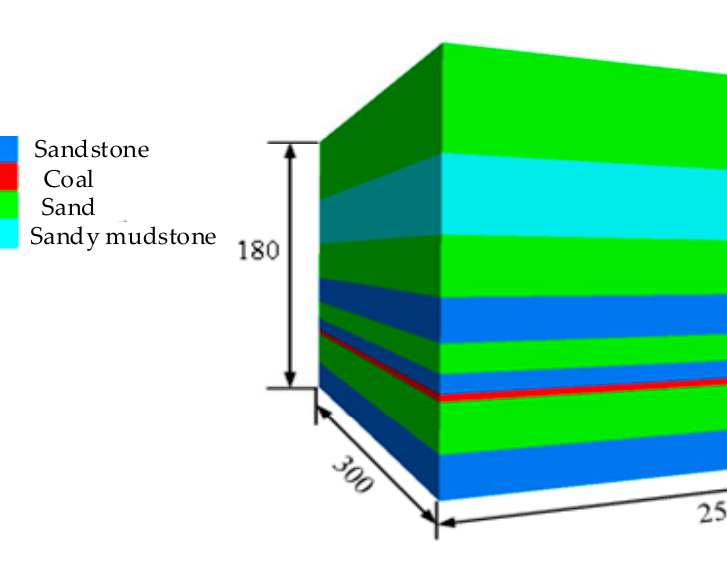
Figure 1. Diagram of the numerical model.